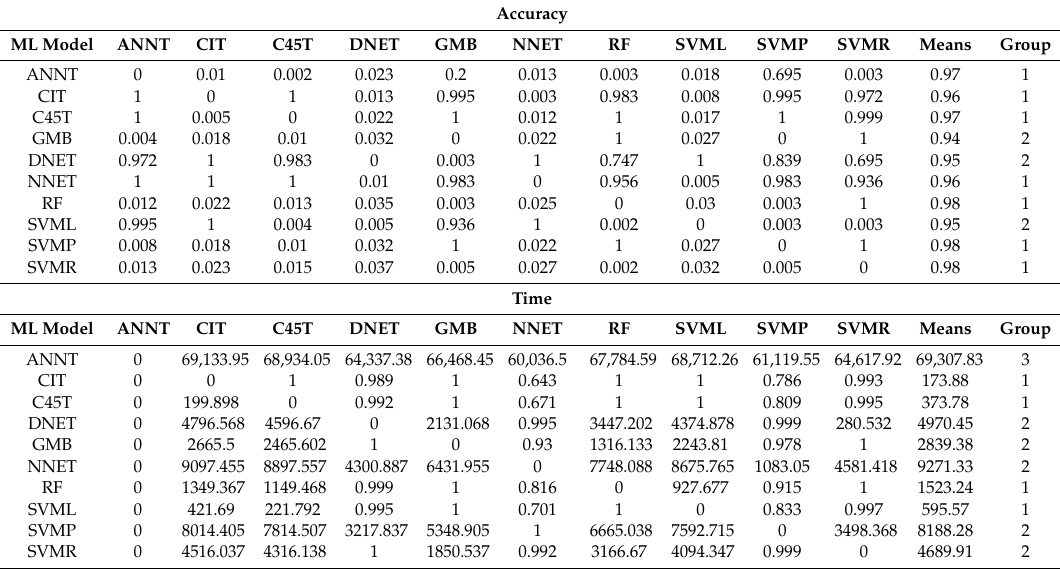
Table 5. Post hoc test p -values—Tukey multiple comparisons of means of the accuracy, kappa and time of ML models, with 95% confidence level.